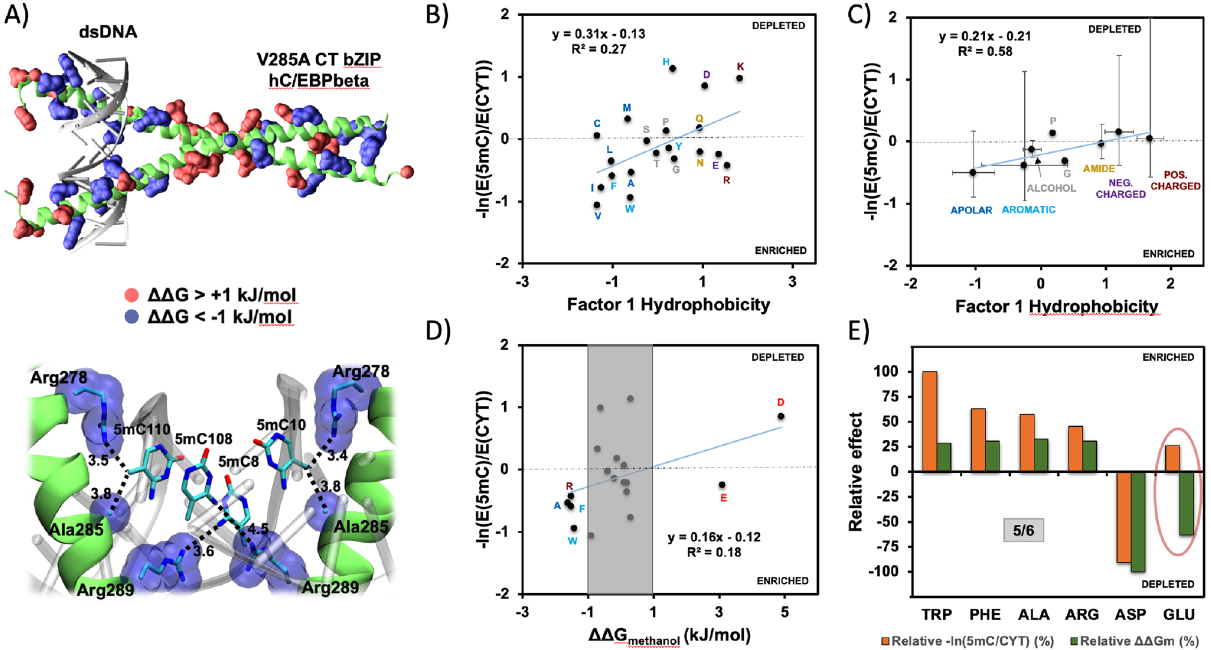
Figure 5. 5mC sidechain binding free energies guide site-specific nucleic-acid/protein interactions. ( a ) Structure of bZIP hC/EBPβ in complex with DNA. The residues with the highest preference for 5mC over CYT in our methanol simulations are colored in blue, while the residues with the highest preference for CYT over 5mC are colored in red. ( b ) Correlation between hydrophobicities of amino acids as captured by Factor 1 scale 65 and their relative preference for 5mC over CYT as derived from high-resolution structures of nucleic-acid/protein complexes (Pearson R 2 = 0.27, p-value = 0.016). ( c ) Same as in ( b ), but with amino acids grouped according to their physicochemical properties (Pearson R 2 = 0.58, p-value = 0.004). ( d ) Comparison between ΔΔG 5mC-CYT (methanol) for different protein sidechains and their relative preference for 5mC over CYT as derived from structural analysis (Pearson R 2 = 0.18, p-value = 0.33). ( e ) ΔΔG 5mC-CYT (methanol) values and the relative preferences for 5mC over CYT as derived from structural analysis for residues with the highest relative preference for either 5mC (Trp, Phe, Ala, Arg) or CYT (Asp, Glu) in methanol